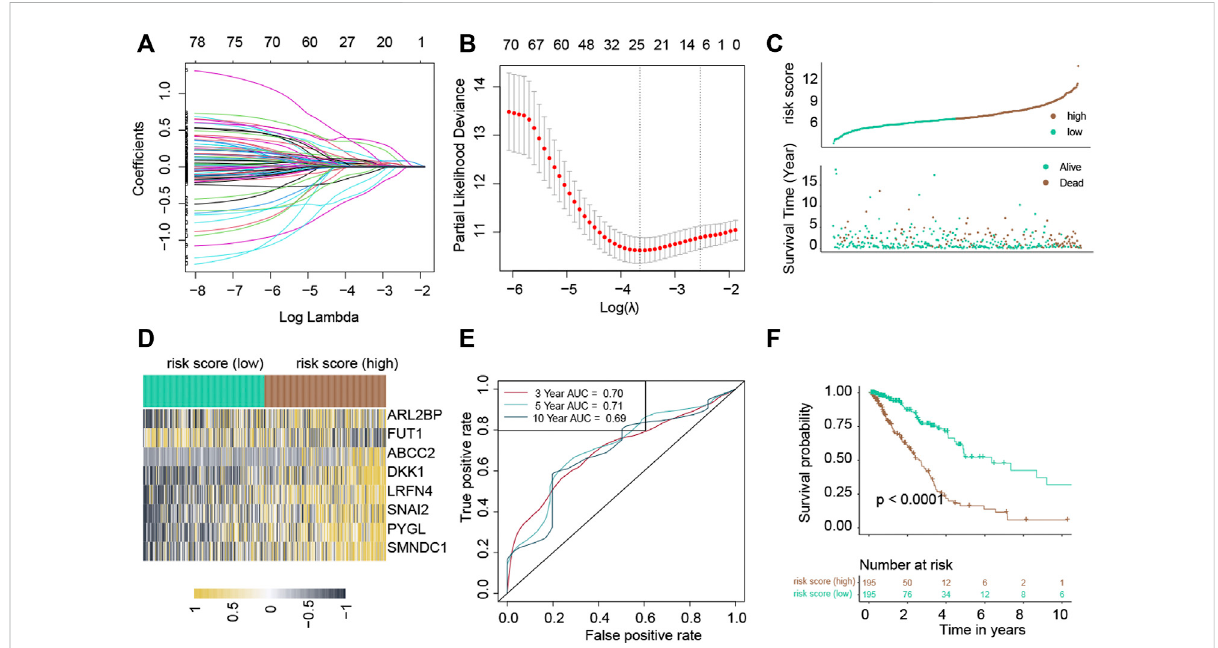
FIGURE 2 Construction of a risk score in the TCGA-LUAD cohort. The LASSO Cox regression analysis. (A) Coef fi cient values of genes. (B) The coef fi cient plot was plotted against the log(lambda) values. (C) Distribution of risk scores and survival summary. (D) Heatmap illustrating the expression of the genes in groups with low and high risk. (E) The risk score for predicting survival was assessed by AUC values. (F) There was a reduced overall survival among individuals in the high-risk group compared to patients in the low-risk